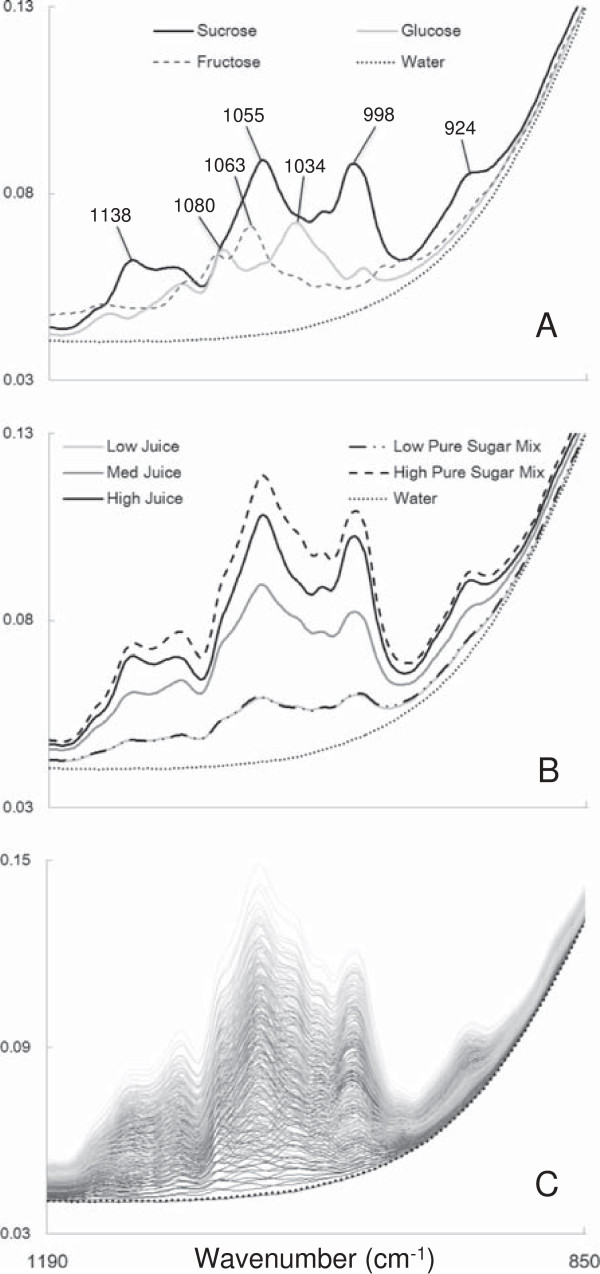
FTIR spectra of pure sugars, S. bicolor juice, and the PLS model calibration set. FTIR spectral fingerprint region collected from: (A) pure sucrose, glucose, fructose, and H2O; and (B)S. bicolor juice containing low, medium, and high concentrations of sugars and a low and high mixture of pure sucrose, glucose, and fructose against a H2O background. (C) Set of 216 samples consisting of varying mixtures of sucrose, glucose, and fructose making up the calibration set. Wavenumbers between 1,190 to 850 cm-1 were plotted. X-axis represents spectral wavenumber (cm-1) and y-axis units are arbitrary. FTIR, Fourier transform infrared; PLS, partial least squares.